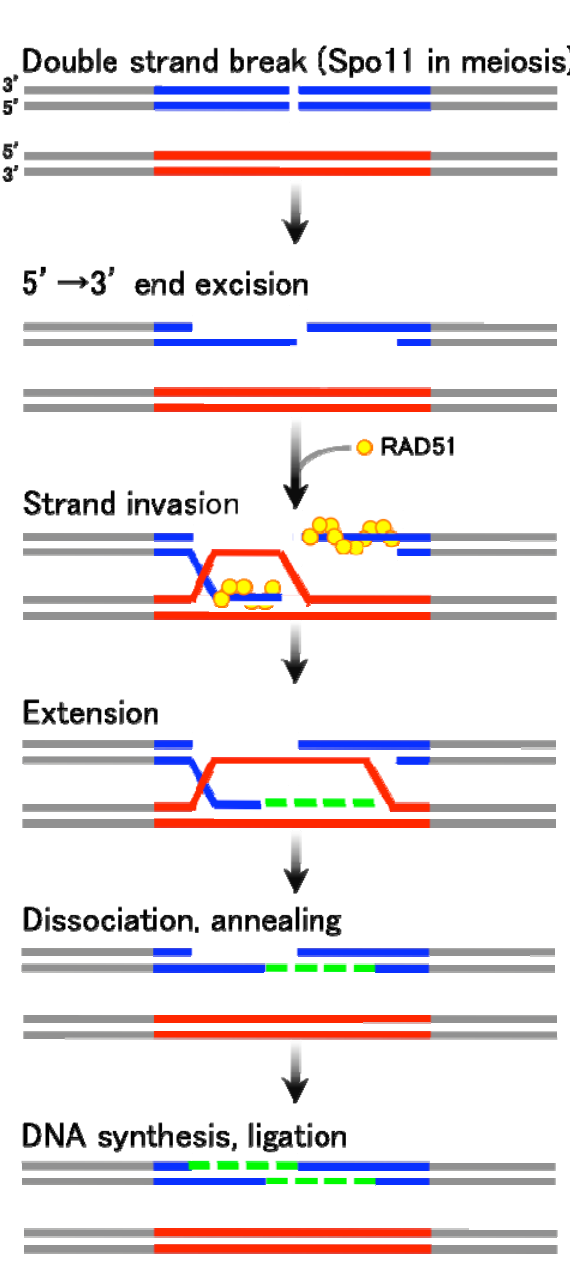
Figure 1. Gene conversion by the Synthesis-Dependent Strand Annealing (SDSA)